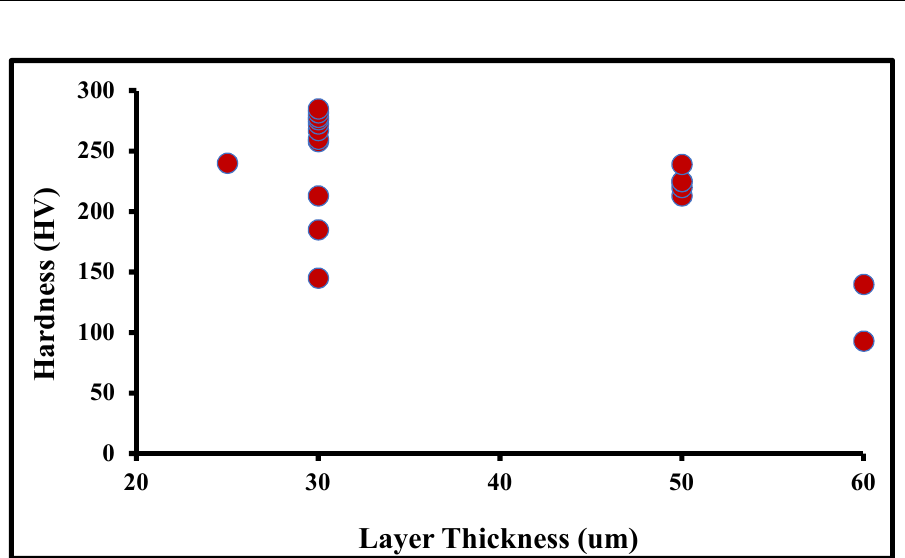
Figure 6. Hardness at varied layer thickness. Wang et al. [11] also reported that with an increase in the energy density, the hard- ness increases up to a certain level after which it reduces due to coarsening of the grains. They examined that the maximum micro hardness of 281.6 HV is obtained at 125 J/mm 3 and further increasing the energy density leads to a reduction in hardness. The overall effect of energy density on hardness from the collected literature data is shown in Figure 7. The increment in hardness with respect to higher energy density is related with the better fusion between and layers and tracks. Further reduction in hardness at a higher energy density leads to keyhole porosity.